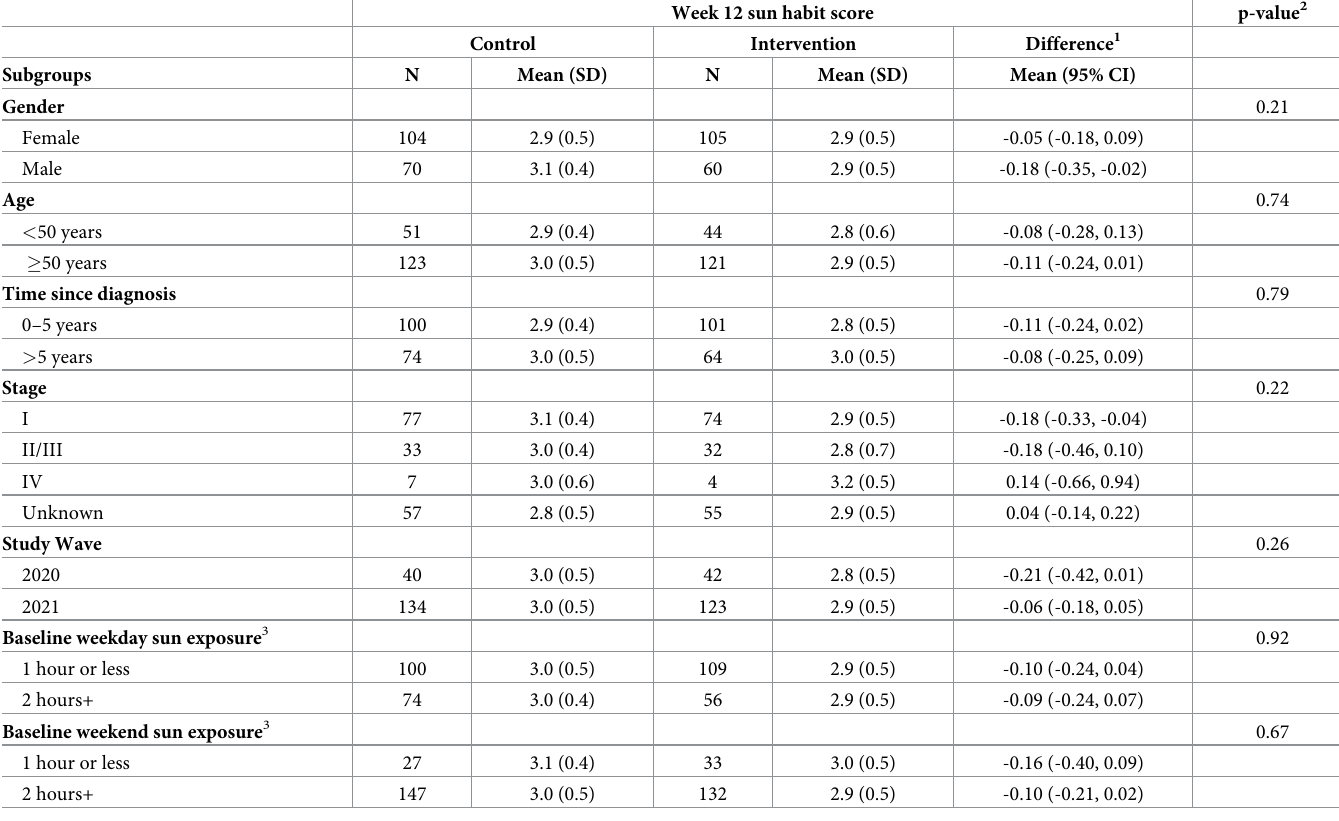
Table 3. Differences in sun protection scores at week 12 between the intervention and control groups across